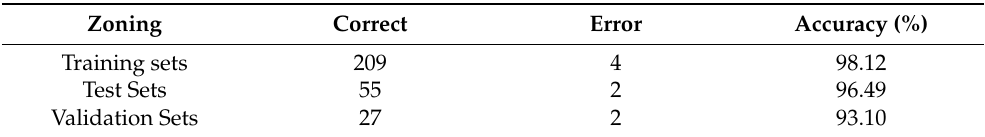
Table 4. Classification results of non-specific intraventricular conduction delay image recognition model.